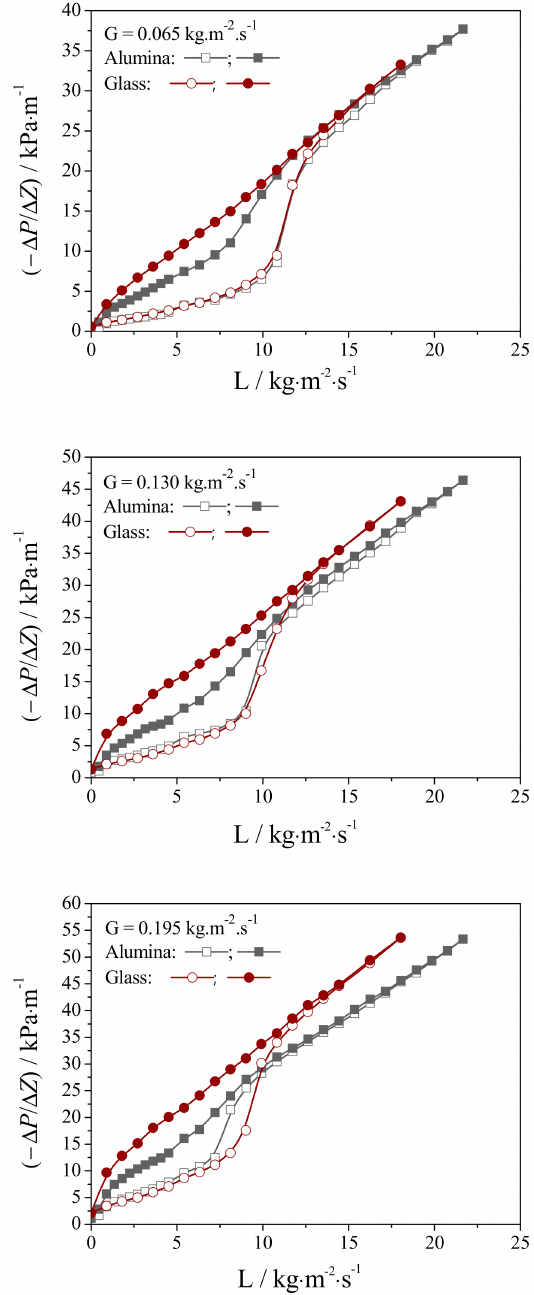
Figure 3. Influence of gas and liquid flow rates on pressure drop